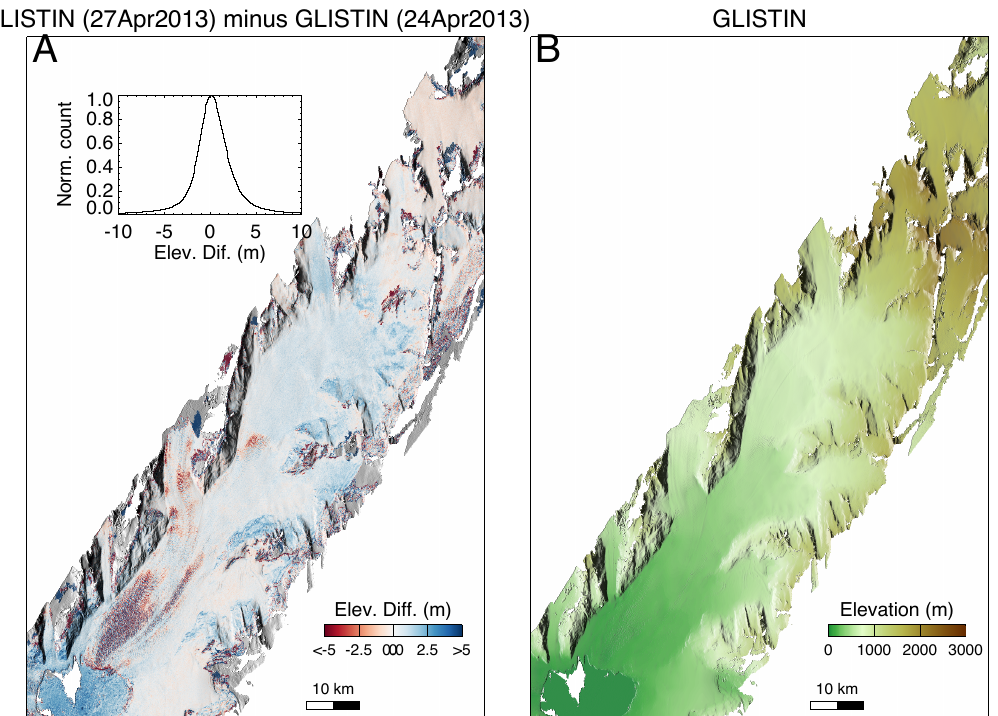
Figure 4. Columbia glacier: ( A ) Height difference maps observed on Columbia glacier over a 3-day interval (see also inset). ( B ) GLISTIN-A digital elevation map generated from a mosaic of two overlapping GLISTIN-A swaths collected 24 April